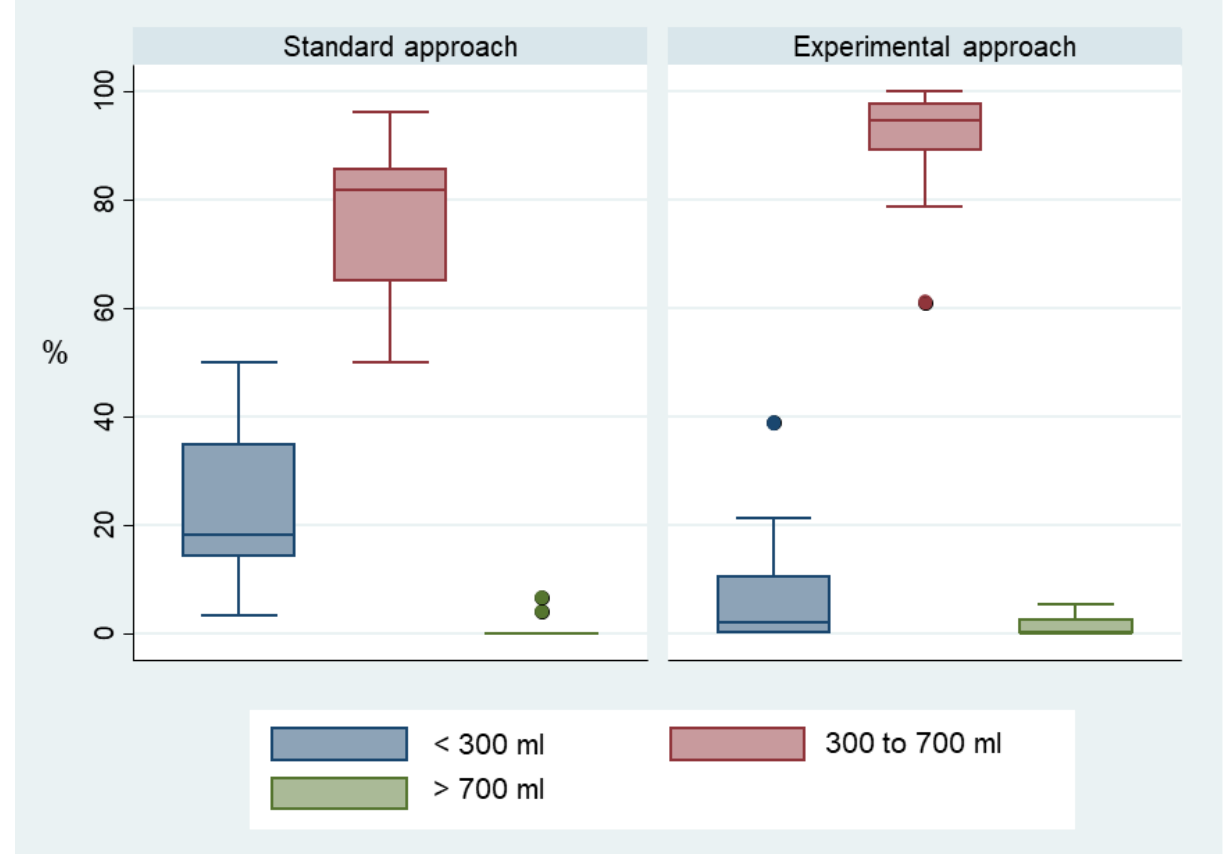
Figure 4. Proportions of ventilations below, within and above volume target value.